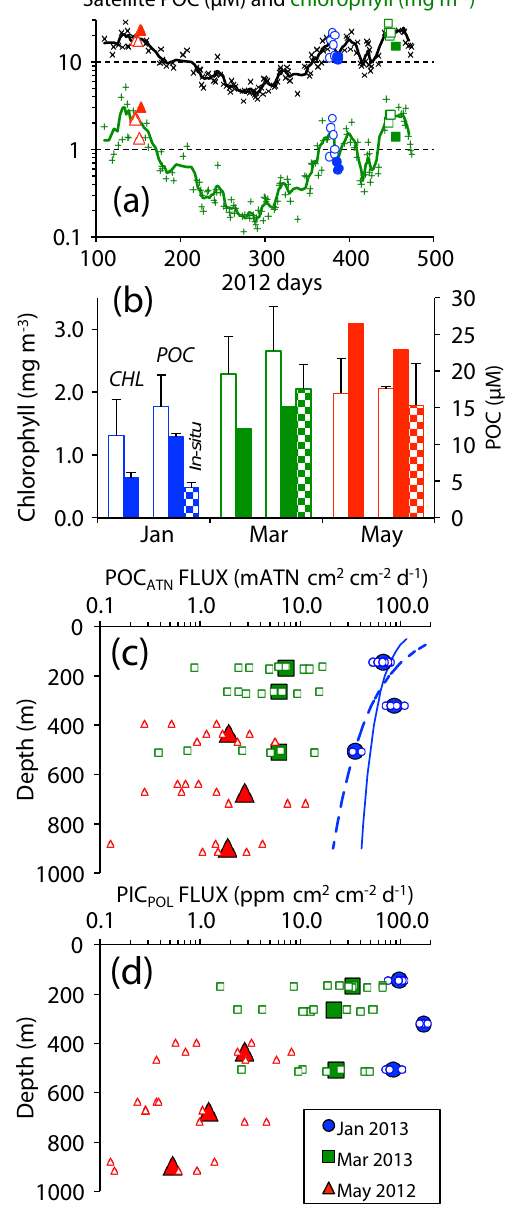
Figure 6. Panel (a) : chlorophyll a and POC from the MODIS Aqua satellite; lines are five-point running means. Color scheme for May 2012 (red), January 2013 (blue), and March 2013 (green). Open and filled graphics in (a) and (b) correspond to the week previous to and during each expedition. Panel (b) : from left to right successive bar pairs depict satellite chlorophyll and satellite POC; crosshatched bars denote 0–20m transmissometer POC. Panel (c) : POC ATN flux for January (blue circles), March (green squares), and May (red tri- angles); the large filled symbols are a grand average for a particular depth, and small open symbols denote 1.6h averaged data. Solid and dashed blue lines are Martin curve fits to January 20013 data corresponding to b values of 0.858 and 0.36, respectively. Panel (d) : PIC POL flux profiles; symbols as in (c)